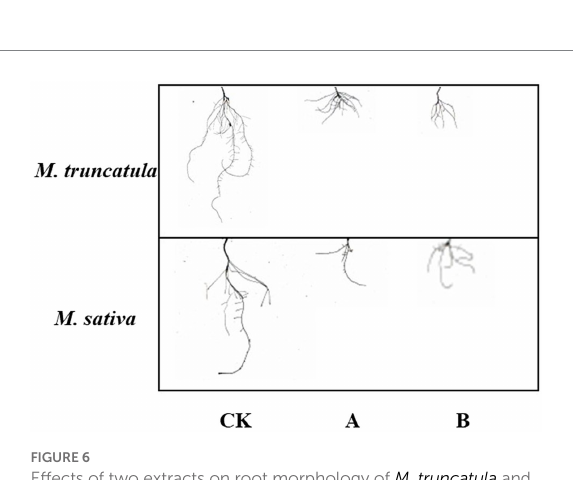
FIGURE 6 Effects of two extracts on root morphology of M. truncatula and alfalfa. CK: Control; A: M. truncatula extracts and B: alfalfa